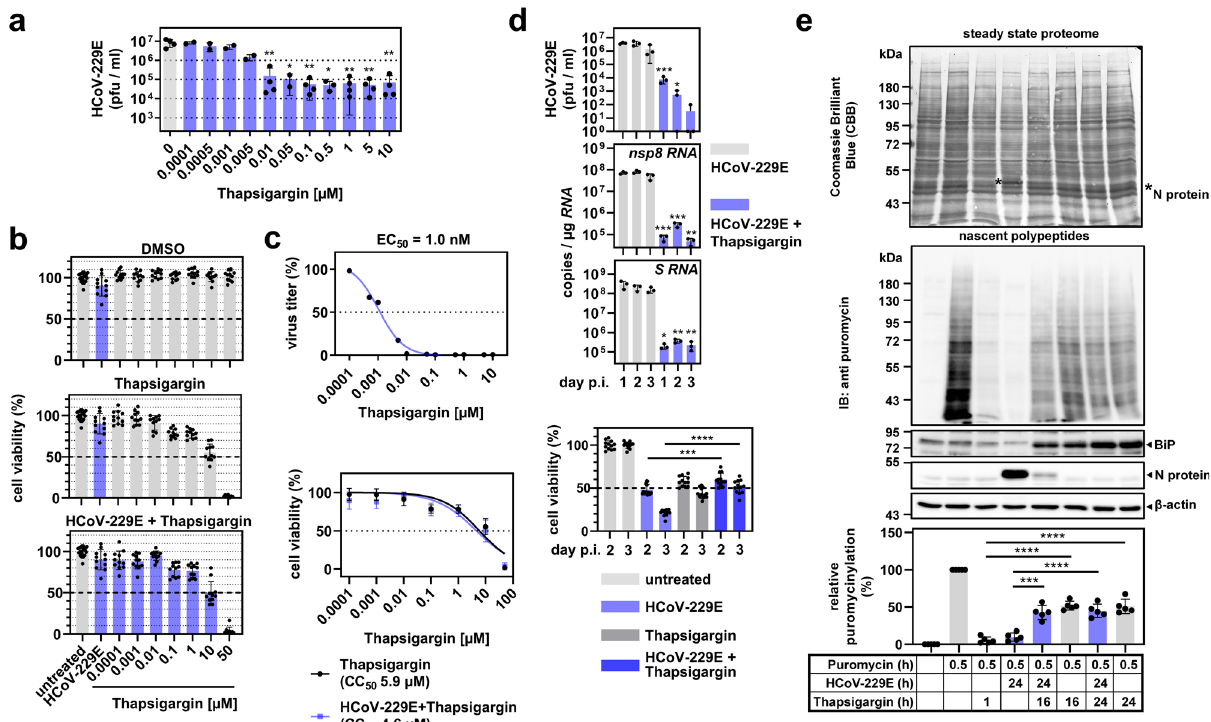
Fig. 3 Thapsigargin mediates dose-dependent, long-lasting inhibition of HCoV-229E replication and leads to partially improved survival and protein biosynthesis of infected cells. a Dose-dependent suppression of HCoV-229E replication in the absence or presence of increasing concentrations of thapsigargin. At 24 h p.i., viral titers of cell culture supernatants were determined (two or more biologically independent experiments). b HuH7 cells were left untreated, or were infected with HCoV-229E (MOI = 1) in the presence/absence of increasing concentrations of thapsigargin or DMSO as solvent control. After 24 h, cell viability was assessed by MTS assay ( fi ve biologically independent experiments). c All data from ( a ) and ( b ) were used to compute the relative estimated half-maximal effective (EC 50 ) (upper graph, means of two or more biologically independent experiments) and cytotoxic (CC 50 ) (lower graph, means ± s.d. of fi ve biologically independent experiments) concentrations of thapsigargin in HuH7 cells infected with HCoV-229E. d HuH7 cells were infected with HCoV-229E (MOI = 1) and treated with a single dose of thapsigargin (1 µ M) as indicated. Viral titers, copy numbers of viral RNAs (detected using nsp8 coding sequence- and S gene-speci fi c primers, respectively), and cell viabilities were determined after 1 − 3 days (three biologically independent experiments). e HuH7 cells were treated and infected according to Fig. 2b. Thirty minutes before harvesting, puromycin (3 µ M) was added where indicated. Total cell extracts were analyzed by immunoblotting. The blot membrane was stained with CBB to assess the steady-state proteomes and then hybridized with anti-puromycin antibodies to detect de novo synthesized nascent polypeptides. Puromycin signals of each lane were normalized to the corresponding CBB staining and were background corrected by subtracting signals of samples in which puromycin had been omitted. The upper graphs show representative images and the lower graph shows the quanti fi cation of fi ve biologically independent experiments. All bar graphs show means ± s.d.; asterisks indicate p values (* p ≤ 0.05, ** p ≤ 0.01, *** p ≤ 0.001, **** p ≤ 0.0001) obtained by two-tailed unpaired t-tests. See Supplementary Fig. 2 for PERK inhibitor